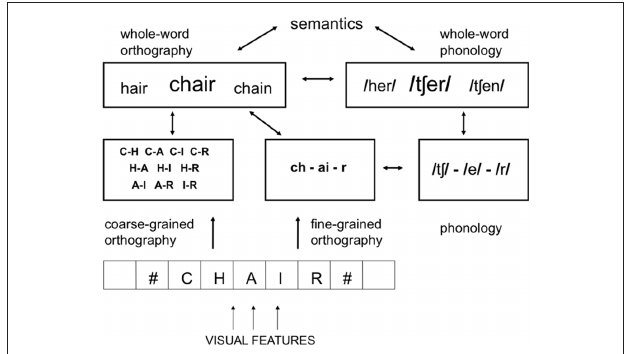
Figure 4 | A multiple-route model of word comprehension in silent reading that integrates the principle of two types of location-invariant sublexical orthographic code within a generic bi-modal interactive- activation model (BiAM). The fine-grained orthographic code provides the level of precision in position coding that is necessary to interface with sublexical phonological representations. Note that the distinction between “direct” orthographic and indirect “phonological” pathways in traditional dual-route models is extended here with the distinction between the two